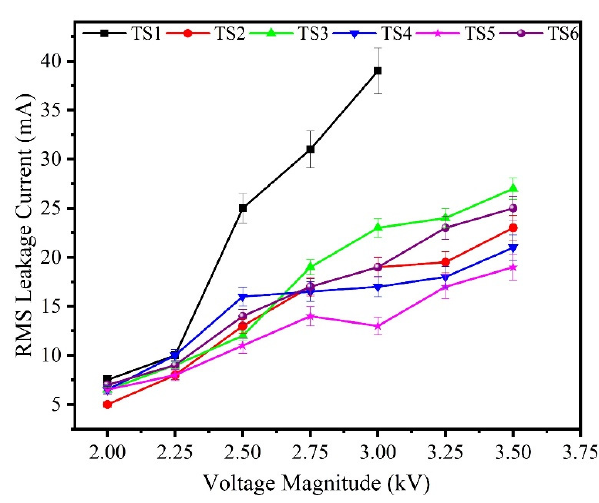
Figure 8. Leakage current of the unaged samples.